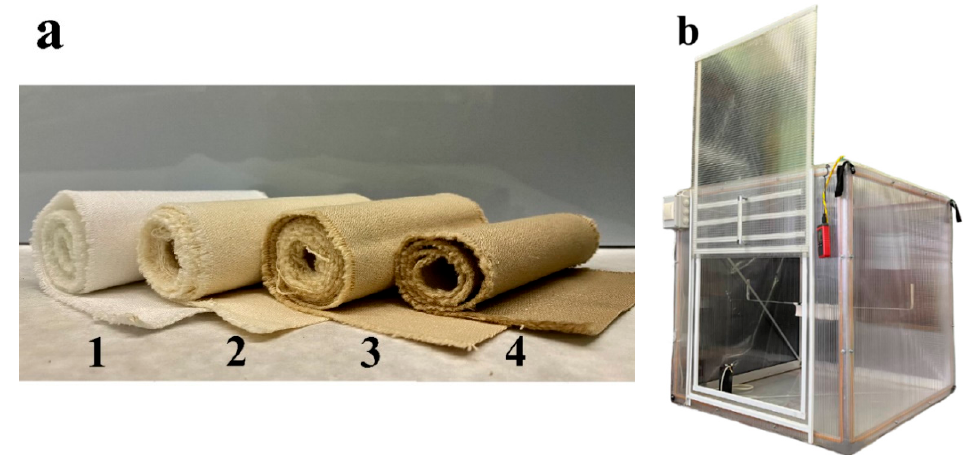
Figure 1. ( a ) Phosphorylated cotton cellulose fabric with different content of phosphoric acid in the phosphorylation mixture: 1—untreated fabric; 2—0 mol L − 1 ; 3—0.80 mol L − 1 ; 4—1.20 mol L − 1 . ( b ) Aspiration camera.